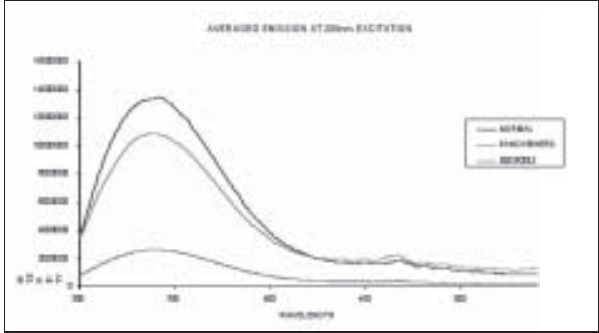
Fig. 1 - Averaged fluorescence emission spectra of normal,